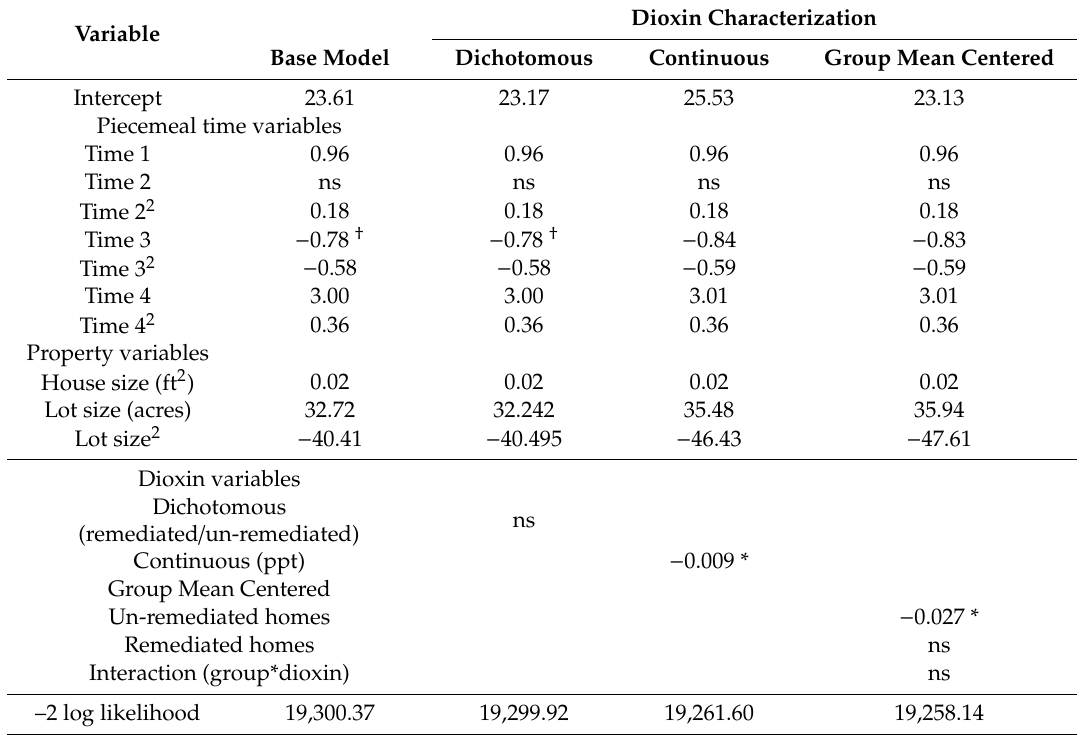
Table 3. Fixed e ff ect estimates from longitudinal, multilevel analyses of the e ff ect of dioxin on assessed home values, in thousands of US dollars. ( n =